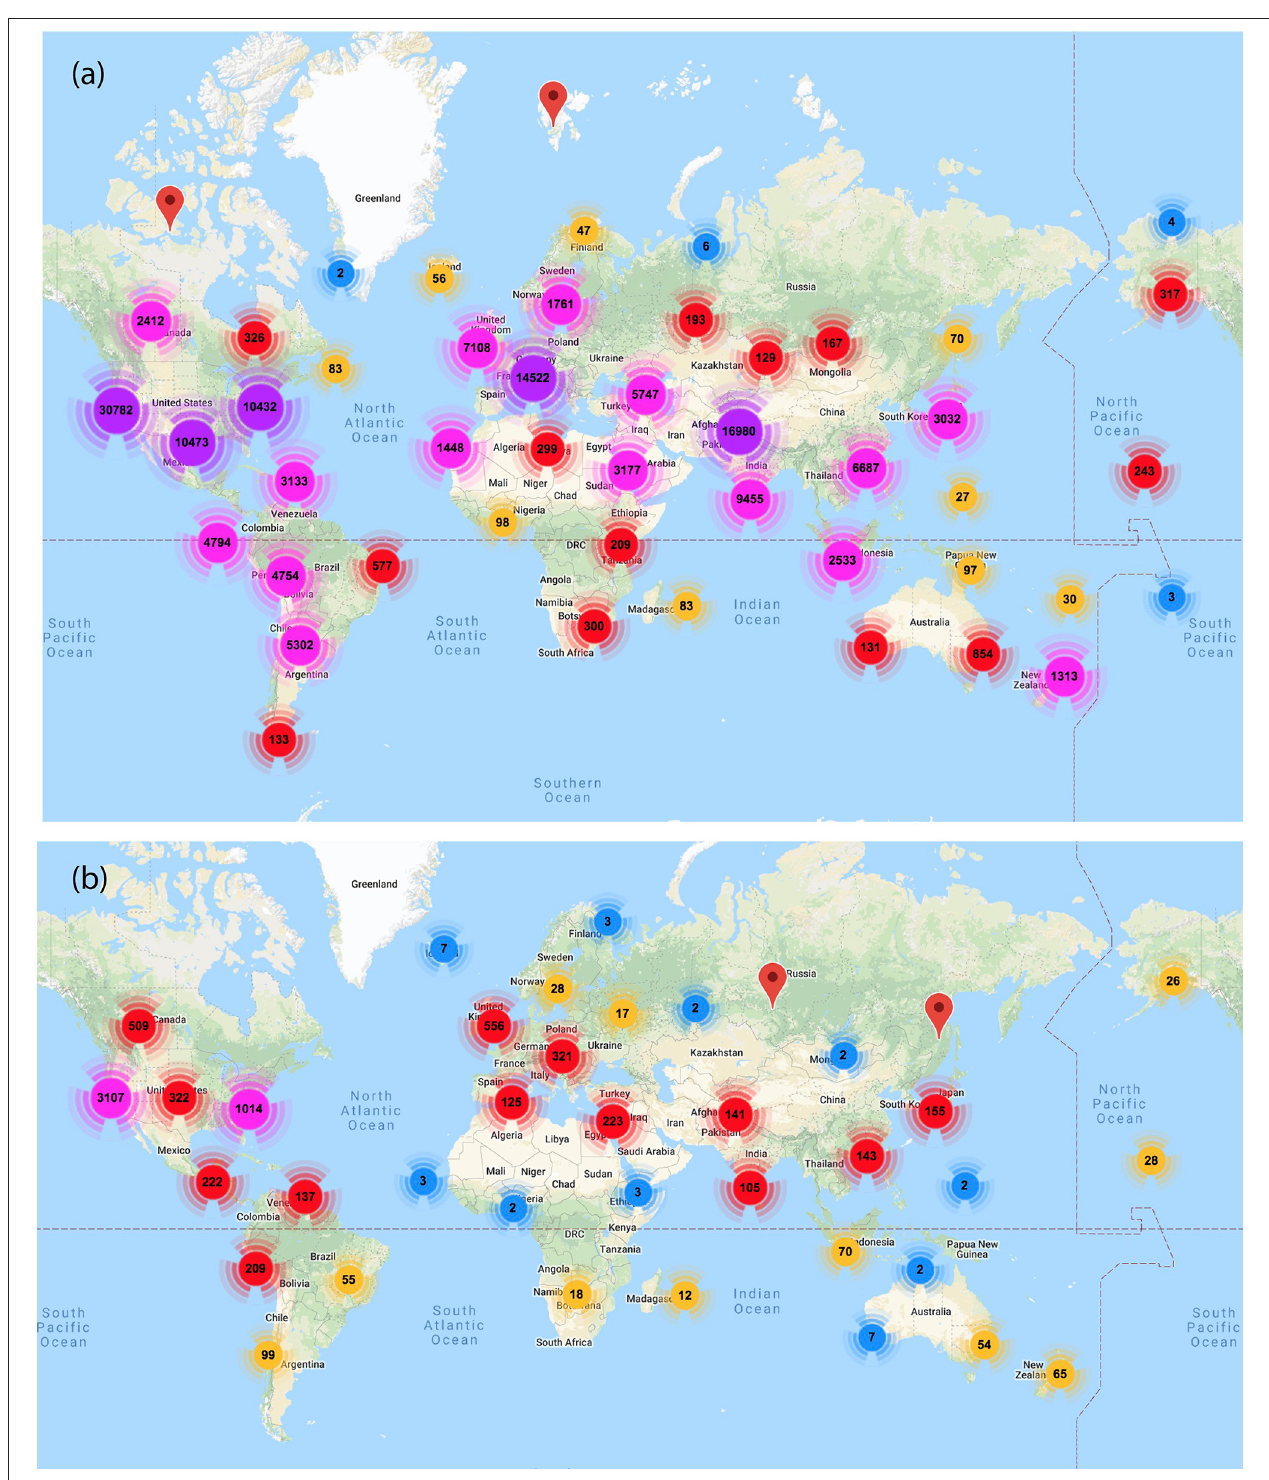
FIGURE 1 | (a) World map of MyShake application downloads, between February 12th, 2016 and July 25th, 2018, clustered by location showing the global reach of the MyShake network. Map data: © 2018 Google. (b) The active users that contribute data weekly for the week of 2018-07-16.